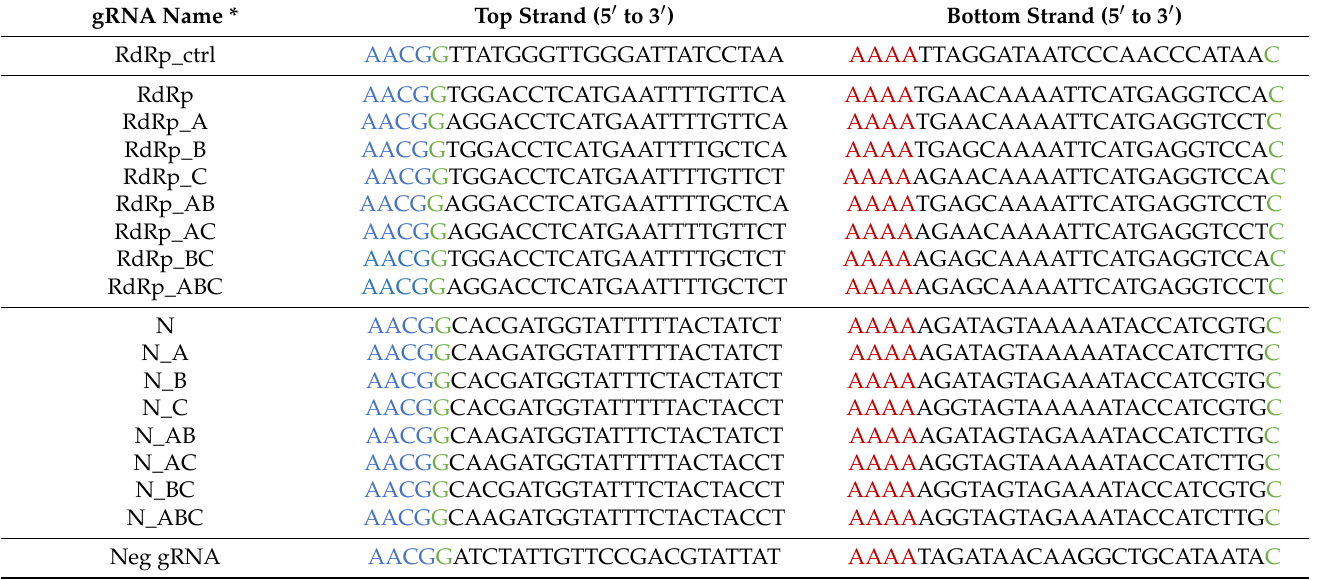
Table 1. Oligonucleotide sequences of gRNA cloned into pXR003. Colored nucleotides correlate to the colors in Figure 2 to designate the promotor, gRNA insert, and terminator sequences.